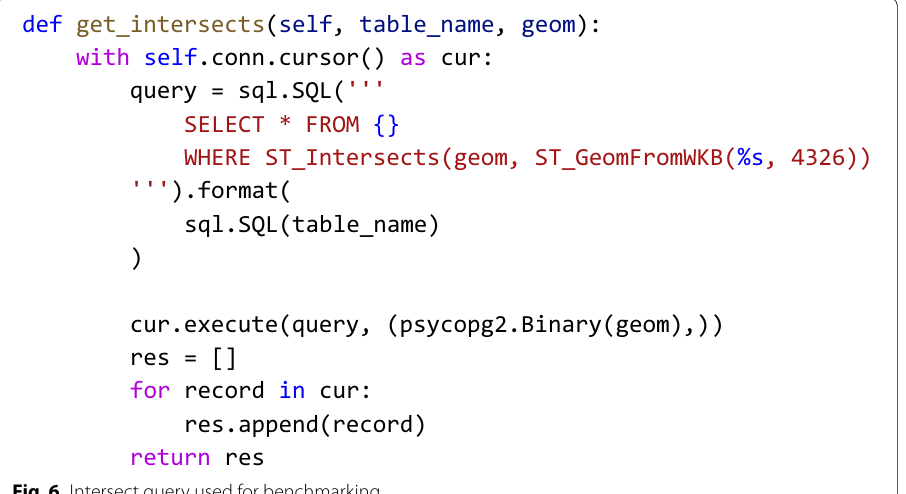
Fig. 6 Intersect query used for